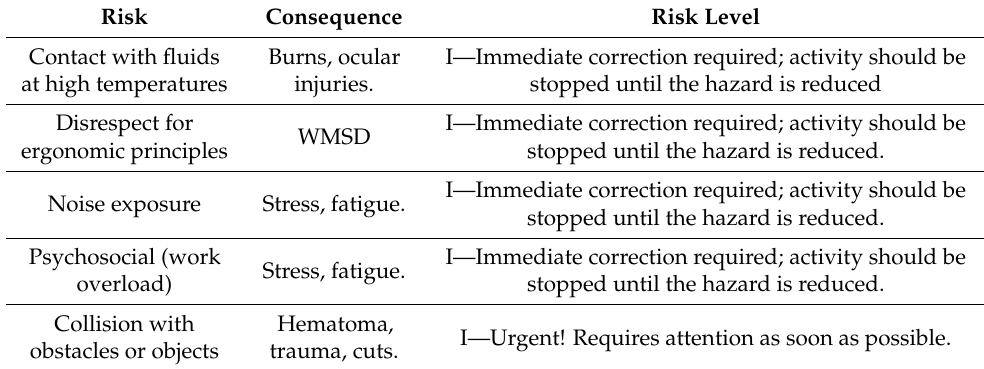
Table 1. Summary of the William Fine assessment.